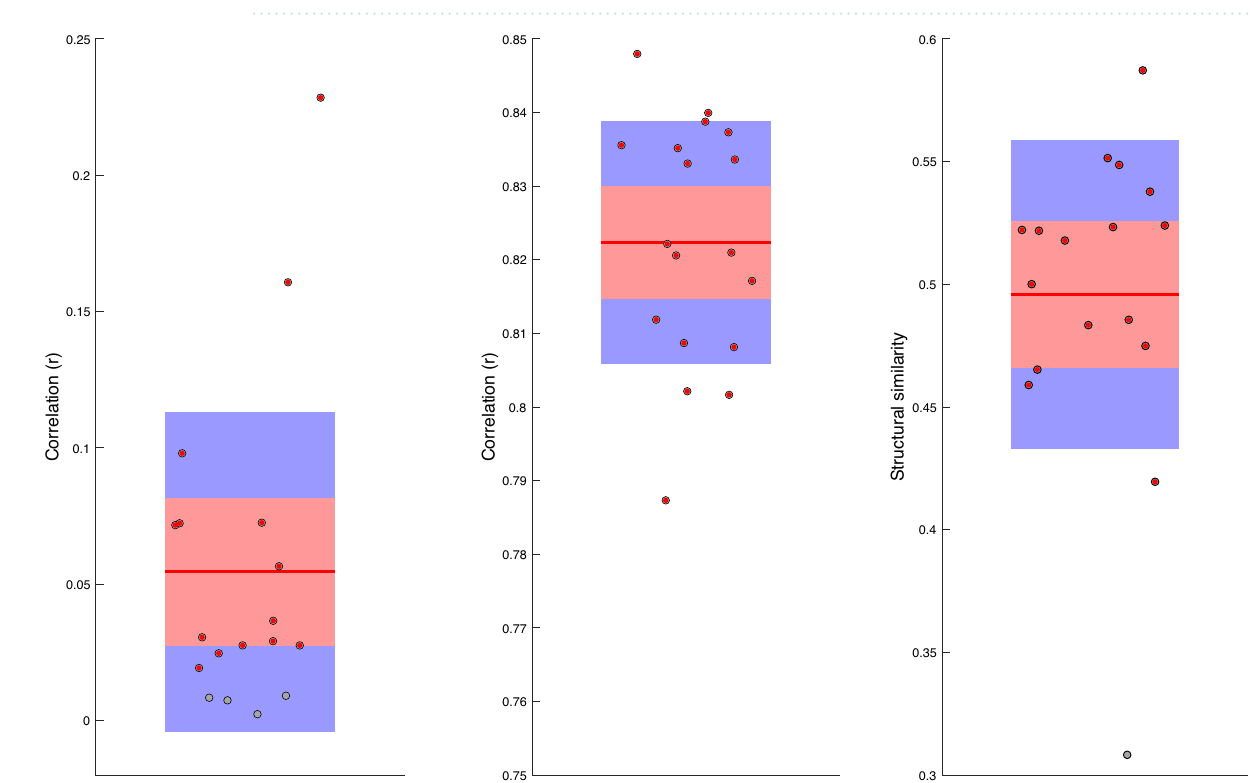
Figure 4. An example of the time-frequency spectrograms of the music played to the participants (top) and the music reconstructed via our fMRI-informed EEG source analysis and biLSTM decoder. The music is downsampled to the same sample rate as the EEG (1000 Hz) and then further downsampled for decoding to 100 Hz.